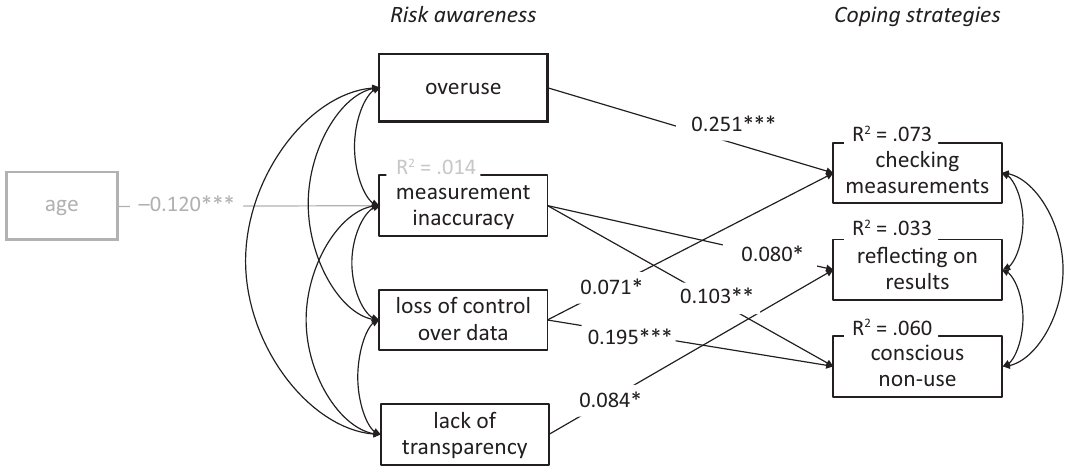
Figure 4. Path model: Risk awareness and coping strategies. Notes: Standardized estimates are shown; only significant paths are shown; *** p < .001, ** p < .05, * p <